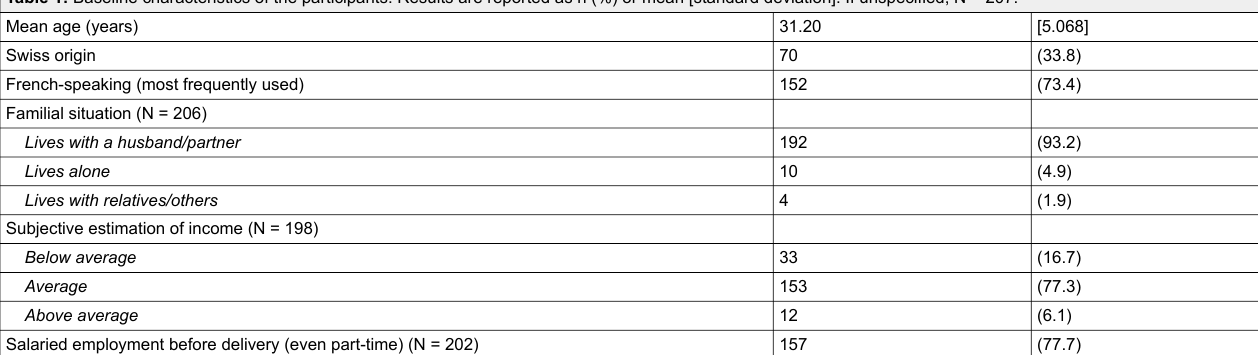
Salaried employment before delivery (even part-time) (N =